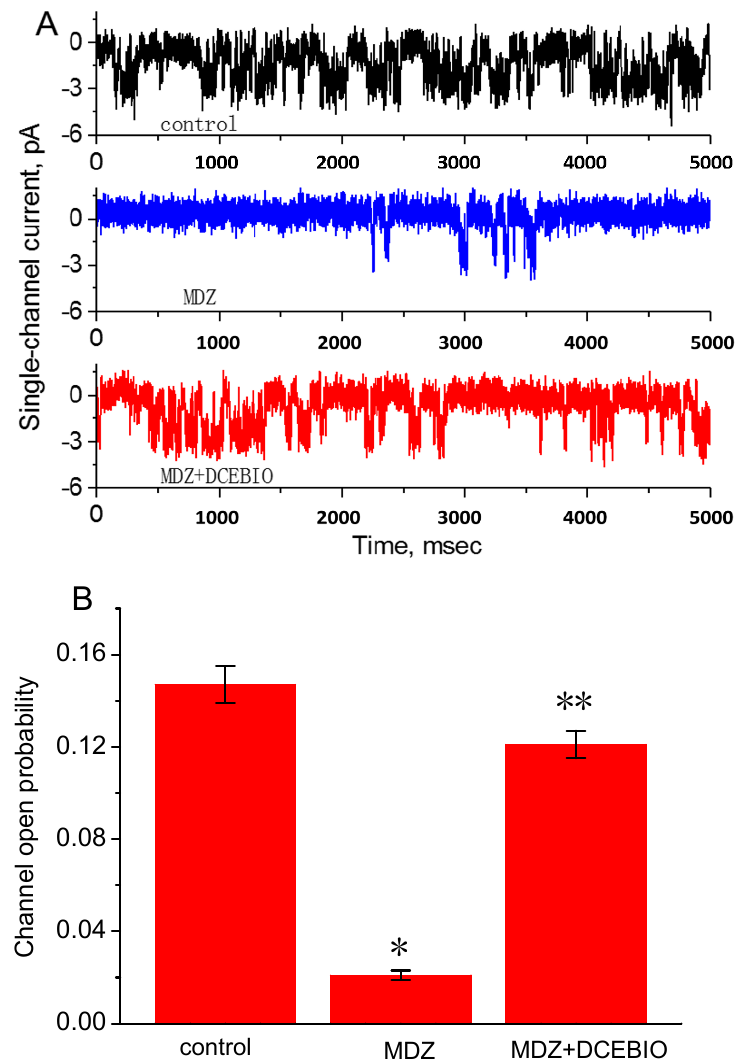
Figure 7. Effect of MDZ on the activity of IK Ca channels in Jurkat T-lymphocytes. In these exper- iments, cells were bathed in high-K + (145 mM) solution containing 1.8 mM CaCl 2 . Cell-attached current recordings were made, and each cell was constantly held at − 60 mV. ( A ) Original IK Ca - channel currents obtained in control, during exposure to MDZ (30 µ M) and MDZ plus DCEBIO (3 µ M). Download deflection indicates the opening event of the channel. ( B ) Summary of the data showing the effects of MDZ and MDZ plus DCEBIO on the probability of IK Ca -channel openings (mean ± SEM; n = 10–12 for each bar). MDZ: 30 µ M MDZ; DCEBIO: 3 µ M DCEBIO. * Significantly different from control ( p < 0.05). ** Significantly different from MDZ (30 µ M) alone group ( p <